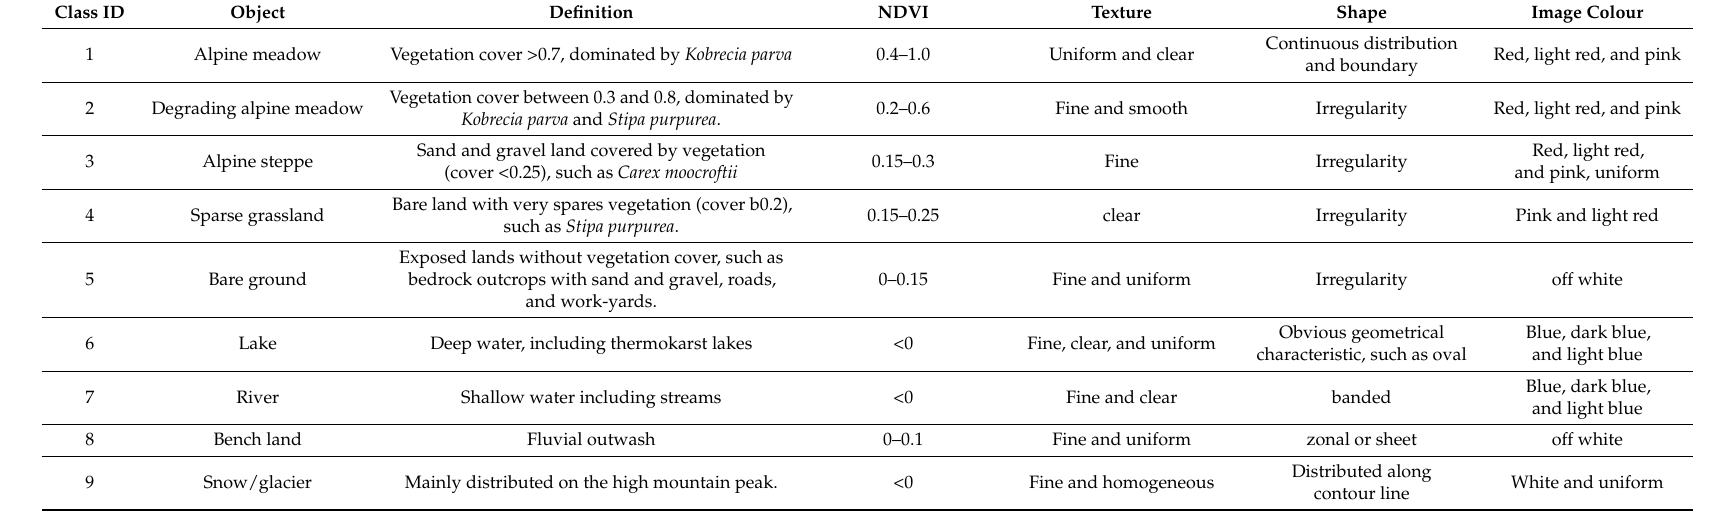
Table 3. Object features of NDVI, texture, shape, and colour for the satellite image used in this